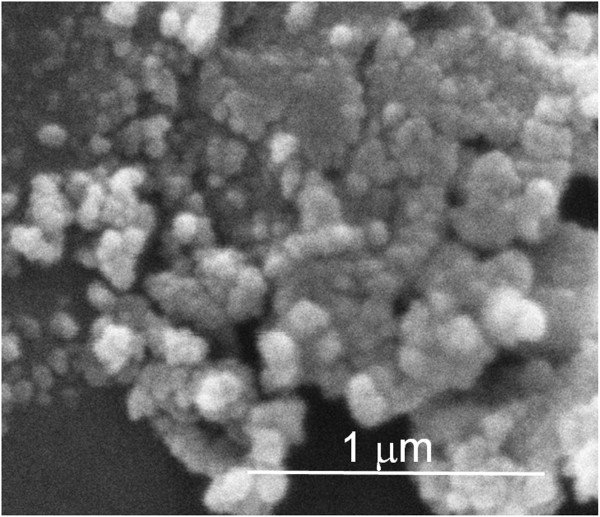
ESEM image of the (Er,Yb):Lu2O3 nanocrystals.